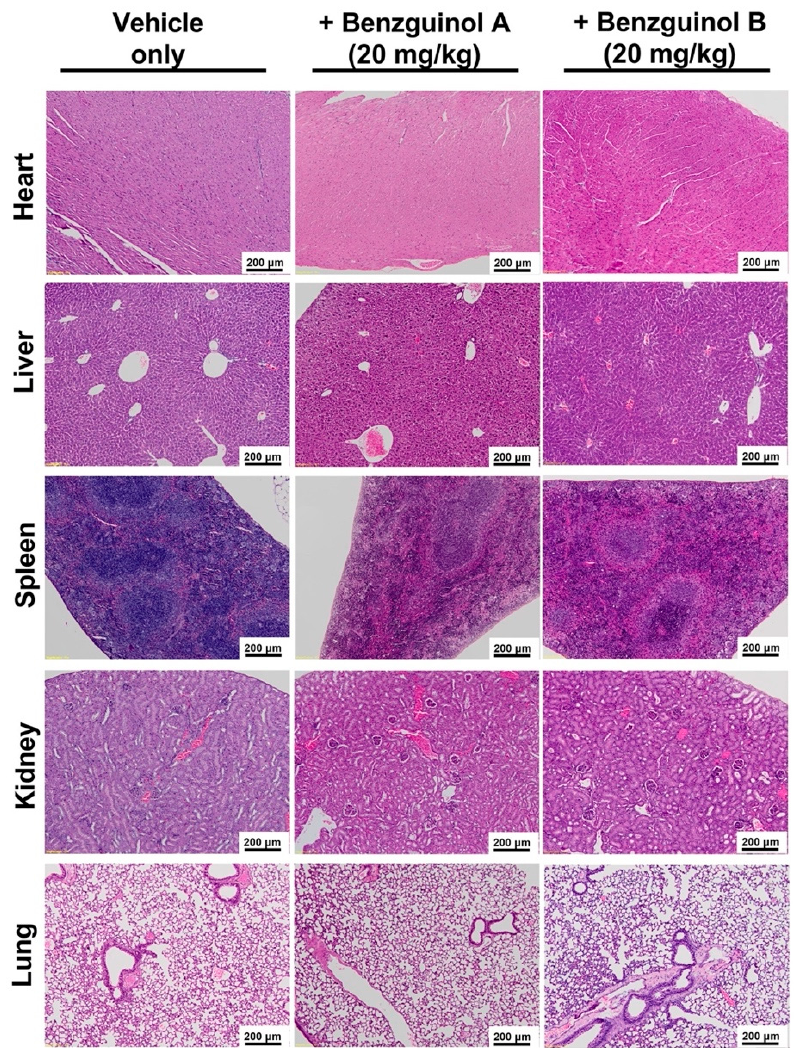
Figure 5. Representative histological images of heart, liver, spleen, lung, and kidneys from benzguinol-treated and control mice harvested at 72 h post-treatment. No morphological abnormalities or changes were observed in mice treated IP with 20 mg/kg benzguinol A, 20 mg/kg benzguinol B, or with vehicle alone. Scale bars: 200 μ m.